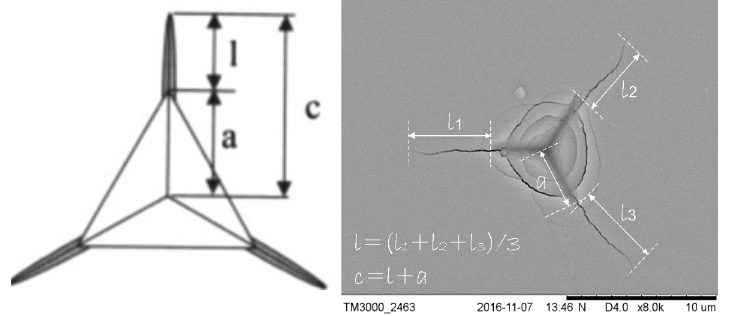
Figure 1. Laugier’s model for determining the fracture toughness K Ic by using the nanoindentation method with the use of a Berkovich indenter for a series of TiBW and TiBCr coatings [20,22].